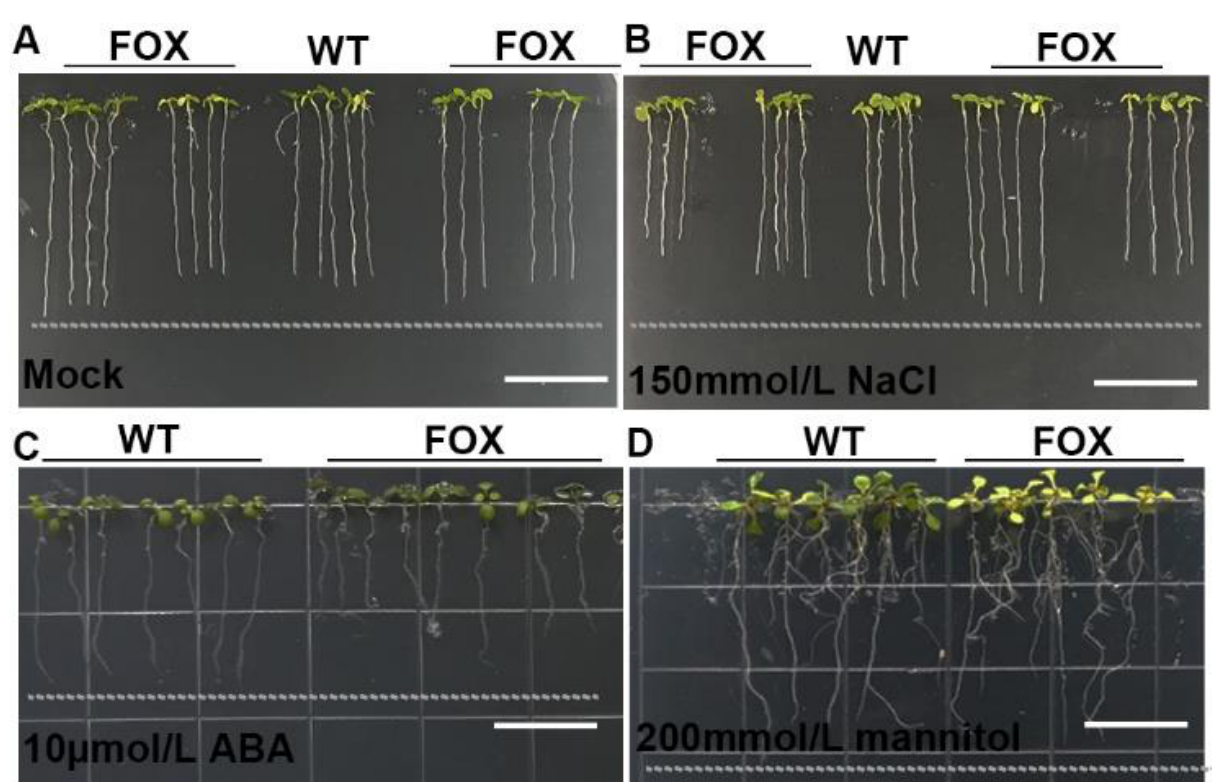
Figure 3. Screening of abiotic stress-resistant FOX mutants. ( A ) Mock. ( B ) 150 mmol/L NaCl treatment for 6 days. ( C ) 10 μmol/L ABA treatment for 6 days. ( D ) 200 mmol/L mannitol treatment for 10 days.